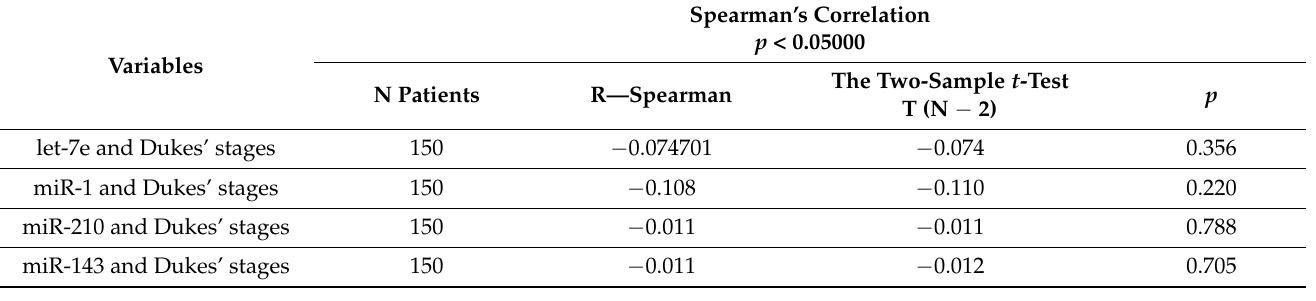
Table 7. Correlation between studied miRNA and the stage of clinical advancement of colorectal Table 6. Correlation between studied miRNA and the degree of tumor differentiation (grading). cancer (Dukes’ classification).